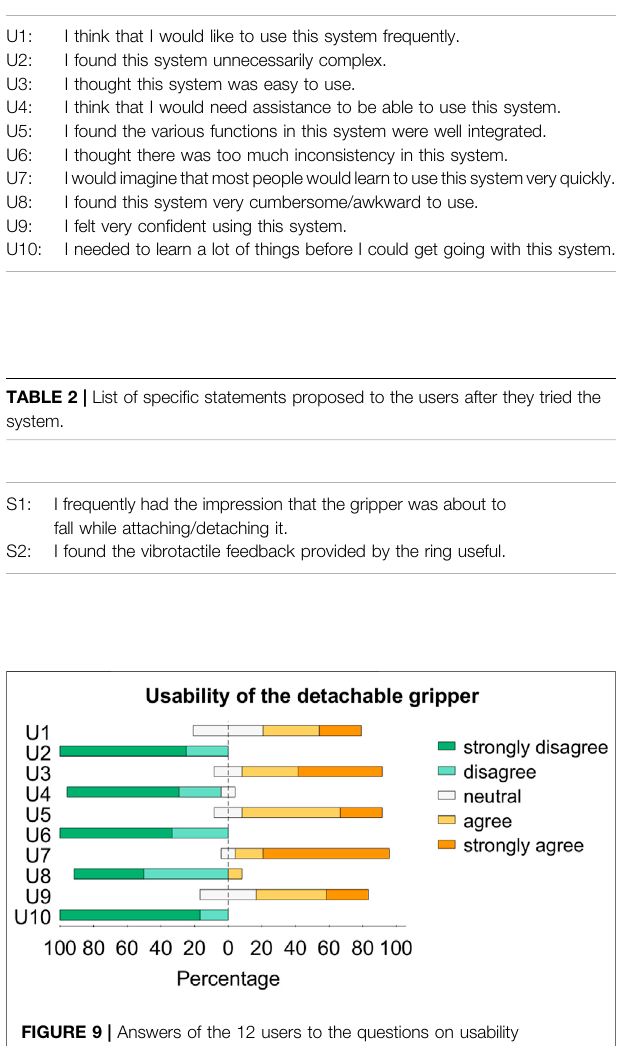
FIGURE 9 | Answers of the 12 users to the questions on usability reported in Table 1 .